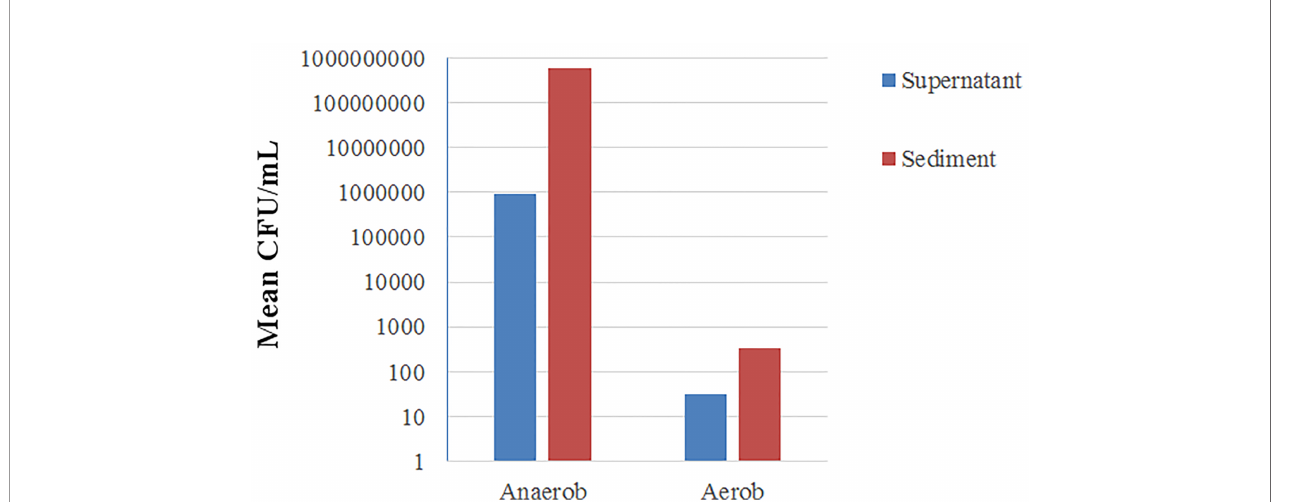
FIGURE 3 | Mean CFU counts on a logarithmic scale in anaerobe and aerobe cultures from supernatant and sediment samples. CFU, Colony-Forming